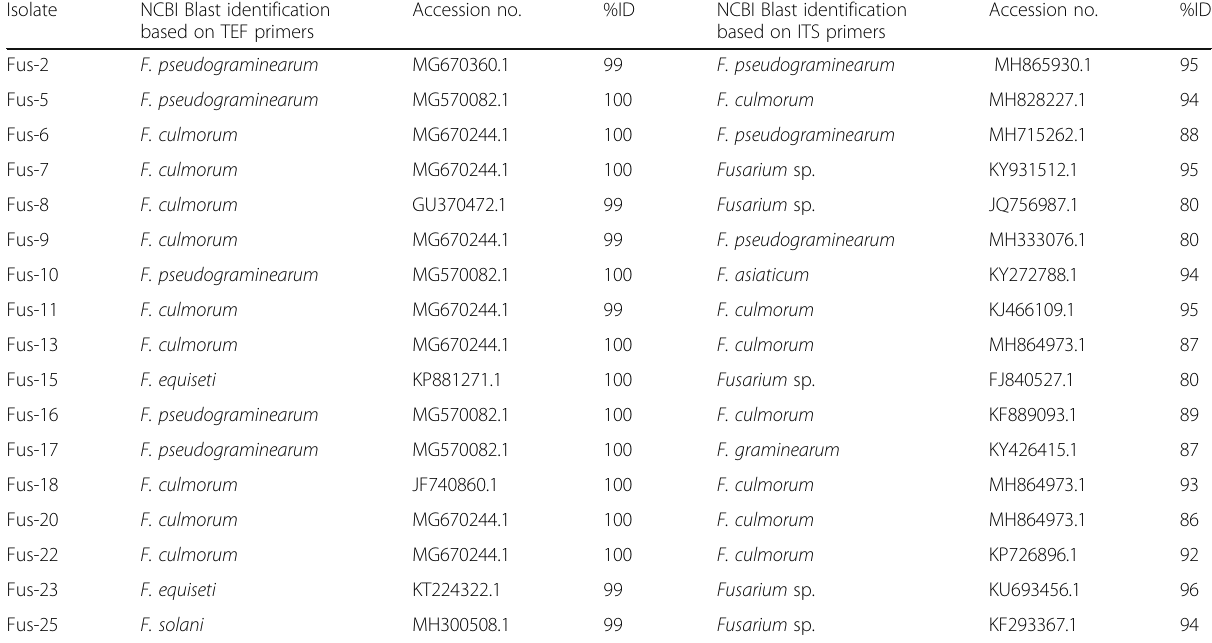
Table 2 Identification of 17 Fusarium taxa isolated from the selected wheat fields based on the sequencing of TEF1- α gene region in bidirectional and ITS1-5.8 rDNA-ITS4